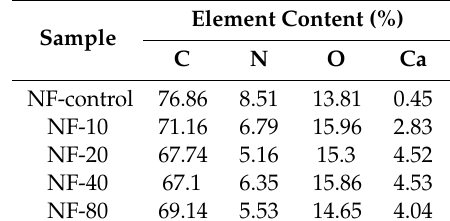
Table 1. Surface element composition of the resulting membranes.